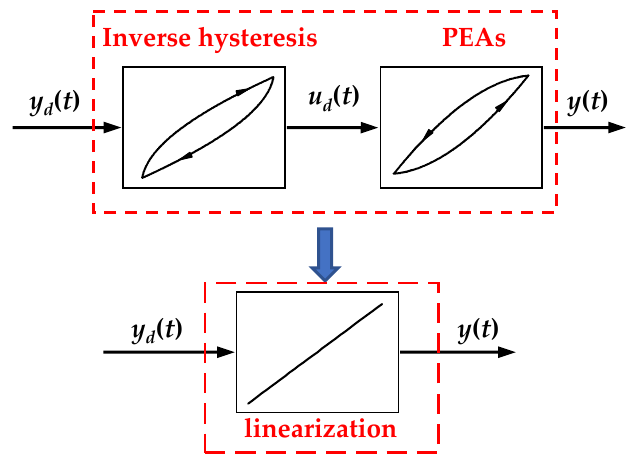
Figure 9. Schematic illustration of feedforward compensation based on inverse hysteresis model.